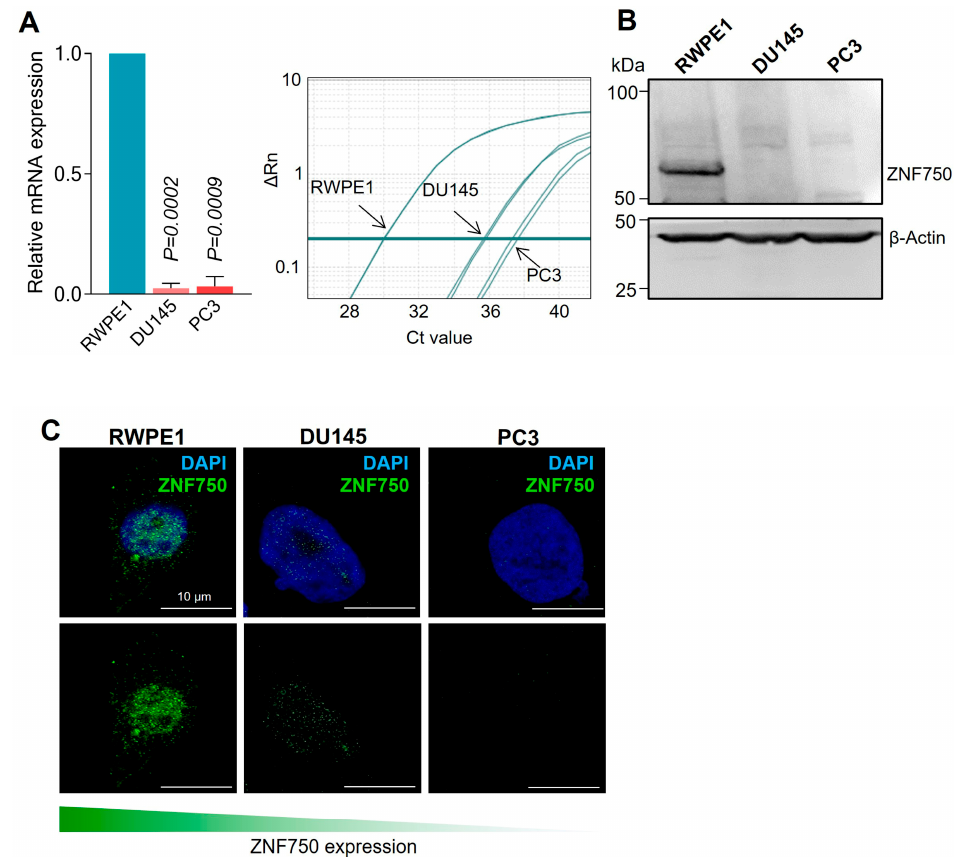
Figure 3. ZNF750 expression is reduced in prostate cancer cell lines. ( A ) ZNF750 mRNA expression in the indicated cell lines assessed by real-time PCR assay. ( B ) ZNF750 protein levels were evaluated by Western blot. A representative image of three independent experiments is shown. ( C ) Confocal microscopy analysis showing that ZNF750 is mainly located in the nucleus of normal prostate epithelial cells. Bars represent means ± SD of three independent experiments. Table 3. Odds ratio of risk of metastasis in patients with prostatic acinar adenocarcinomas. Odds Ratio p 95% C.I. (EXPB)